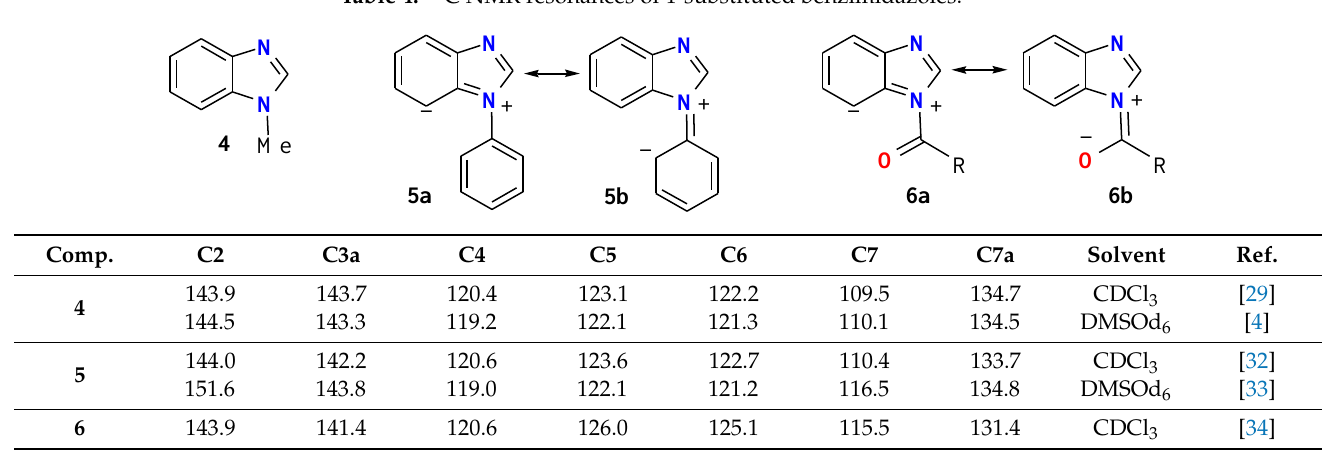
Table 4. 13 C NMR resonances of 1-substituted benzimidazoles.